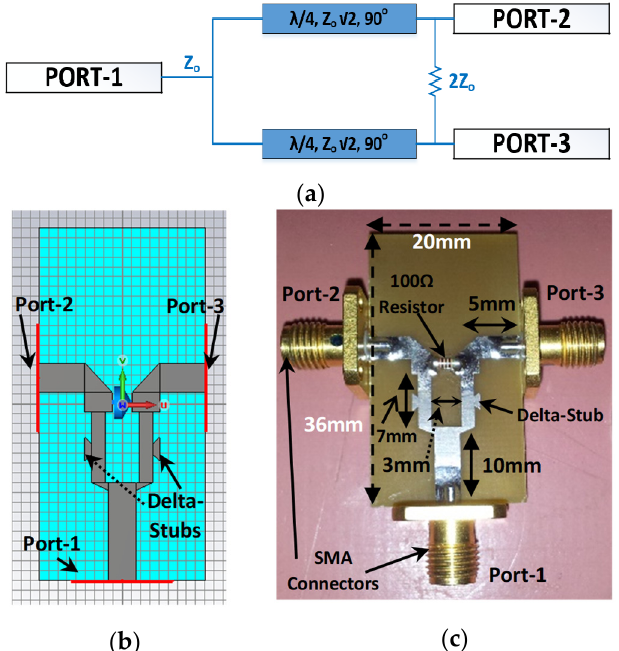
Figure 1. Shows ( a ) transmission-line circuit of an equal-split WPD [8], ( b ) simulated design, and ( c ) fabricated prototype of delta-stub-based 1 × 2 WPD.